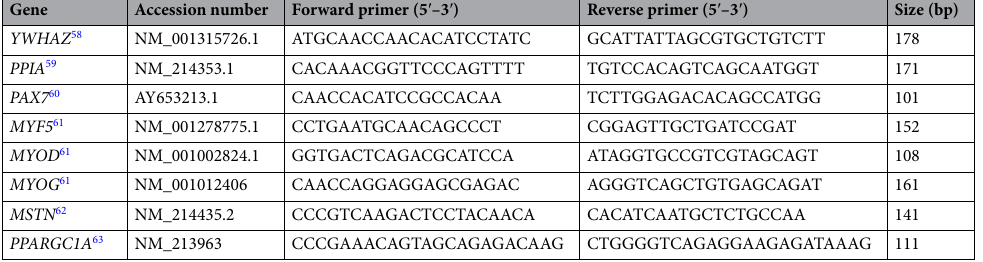
Table 2. Primer sequences for